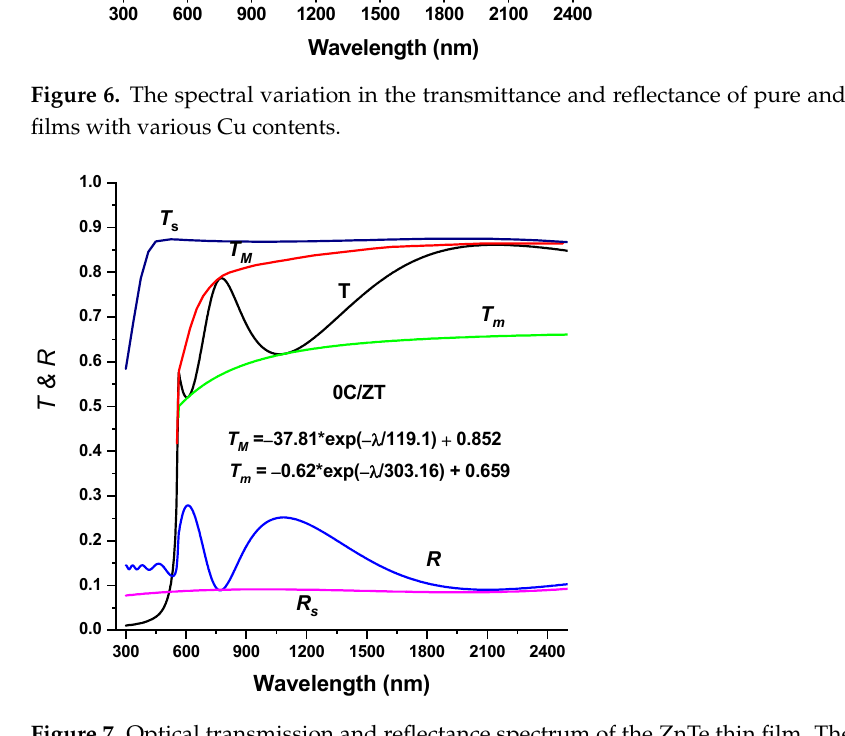
Figure 7. Optical transmission and reflectance spectrum of the ZnTe thin film. The top and bottom transmittance envelopes, T M and T m and T s and R s , are both shown.